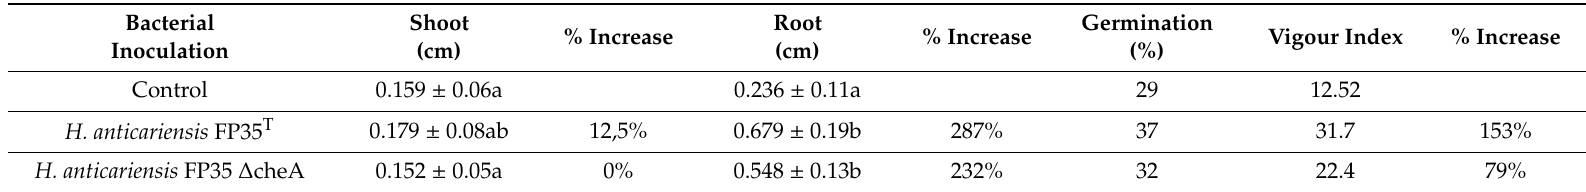
Table 1. E ff ect of wild-type H. anticariensis strain FP35 T and its mutant H. anticariensis FP35 ∆ cheA on shoot length, root length, germination and vigour index of Salicornia